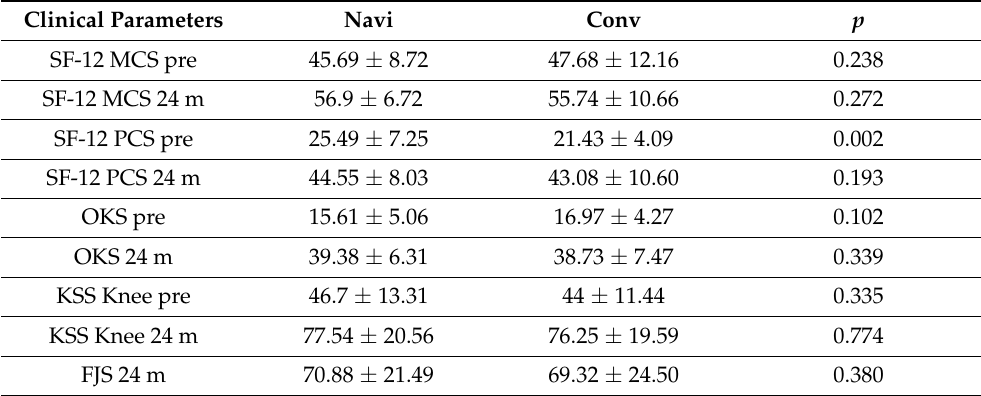
Table 3. Clinical parameters.